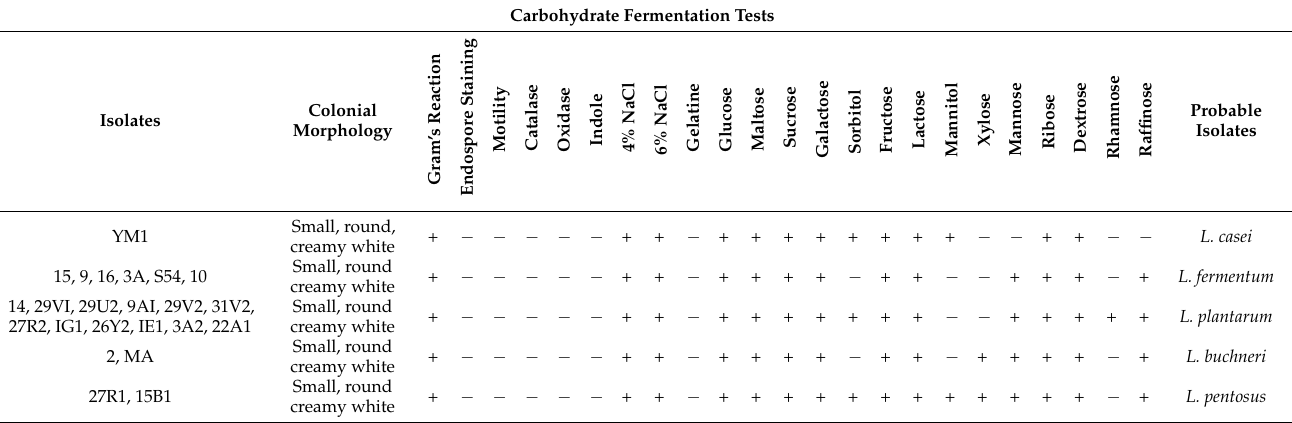
Table 1. Morphological and biochemical characteristics of LAB isolates from fermented milk.